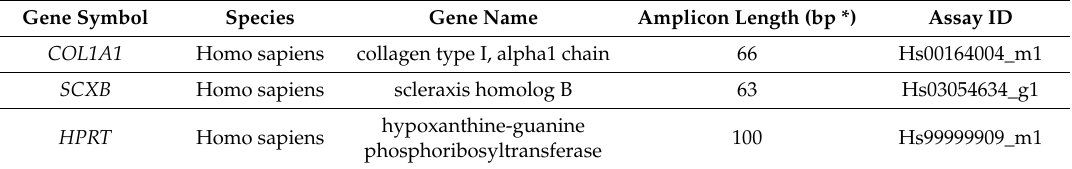
Table 2. Primer sequences used for